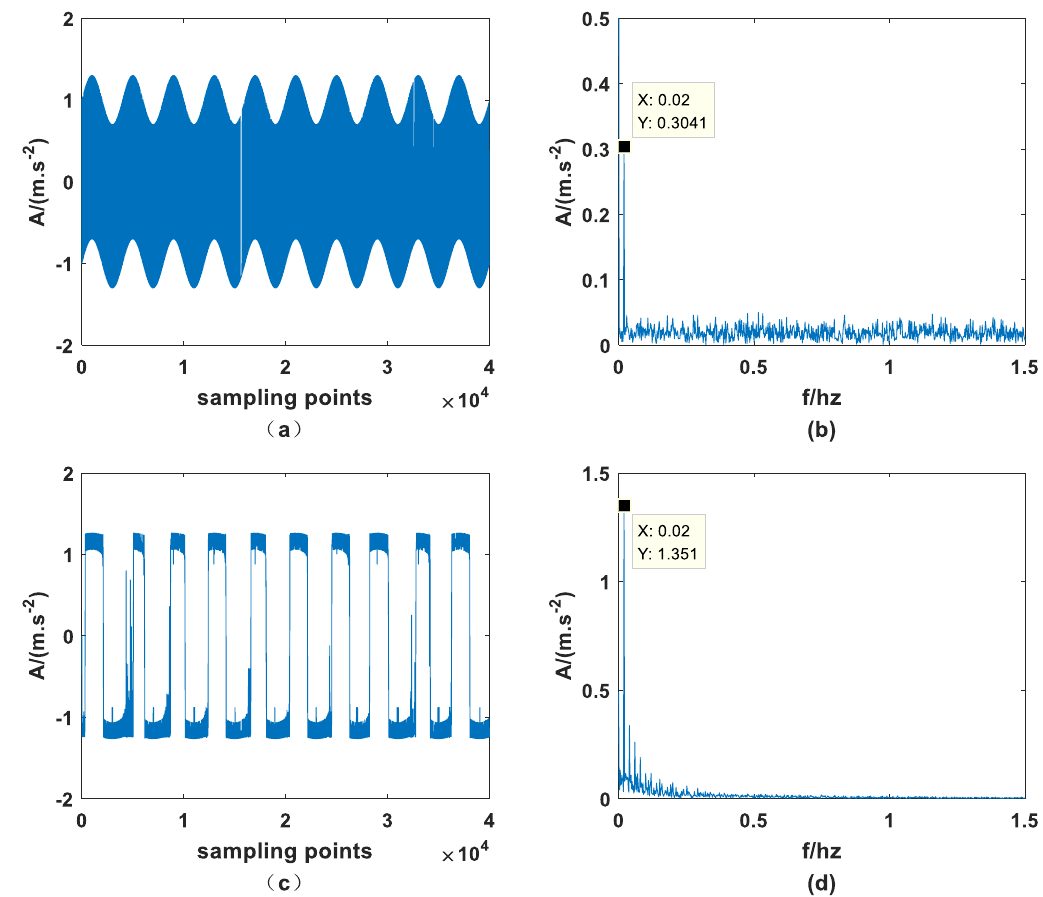
Figure 3. Original signal and output signal: ( a ) input time domain signal, ( b ) input frequency domain signal, ( c ) output time domain signal, ( d ) output frequency domain signal ( m = 3.0, p = 0.5, q = 1.2).